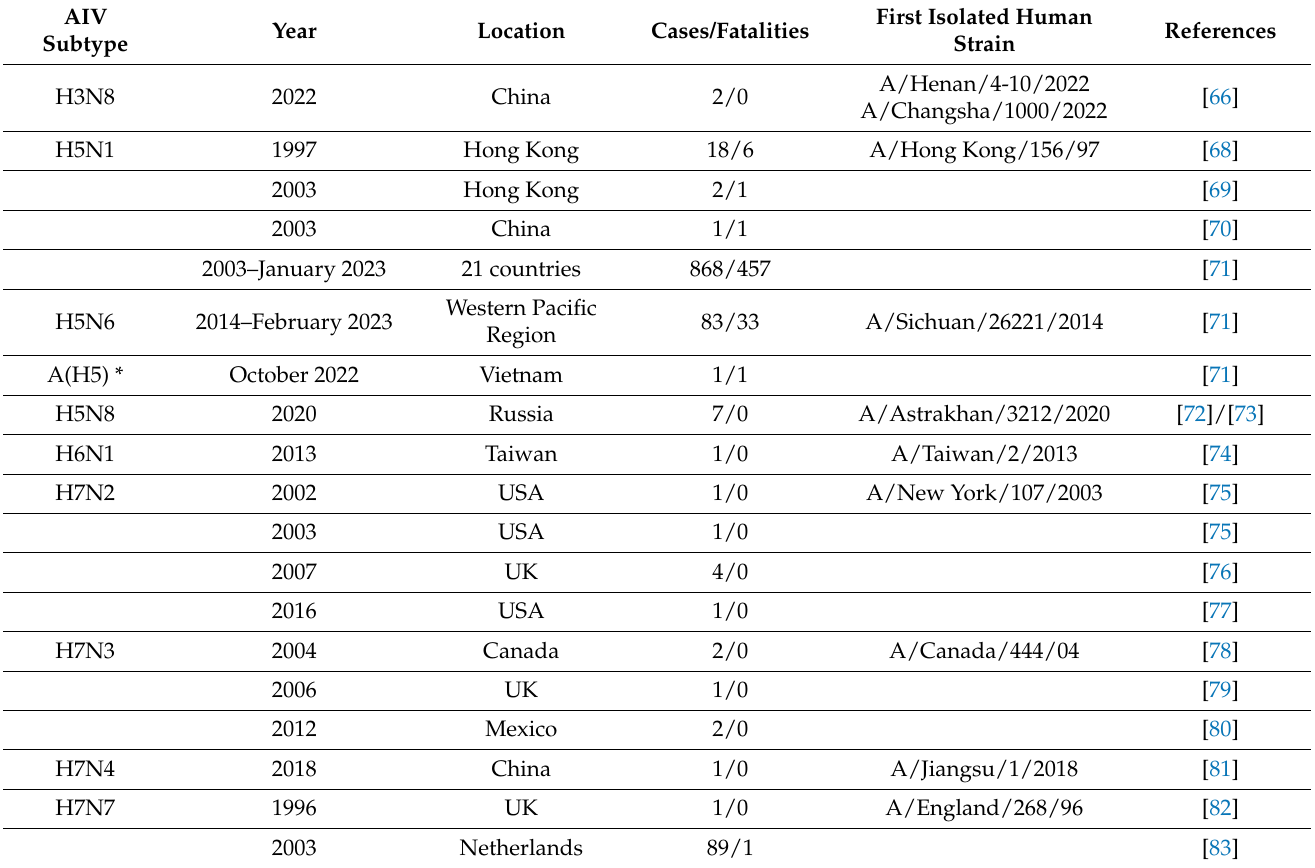
Table 2. Summary of all human infections caused by the avian influenza